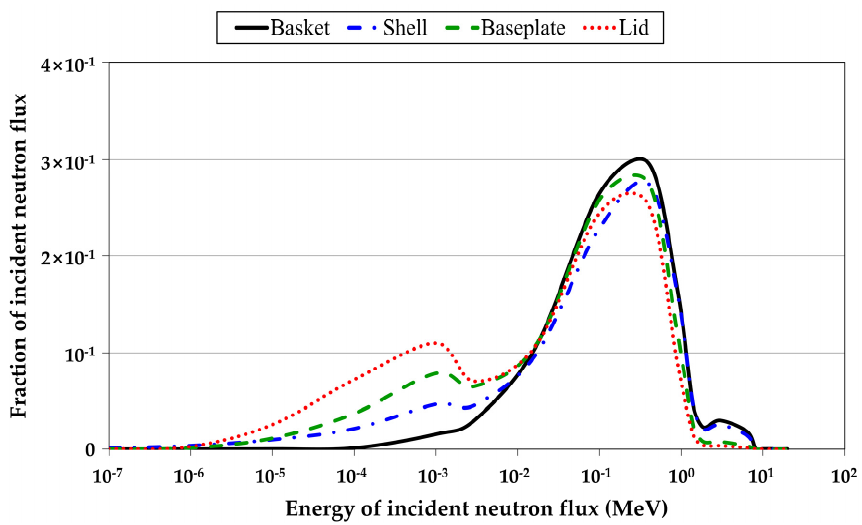
Figure 5. Fraction of incident flux of neutrons having a specific energy in each component.